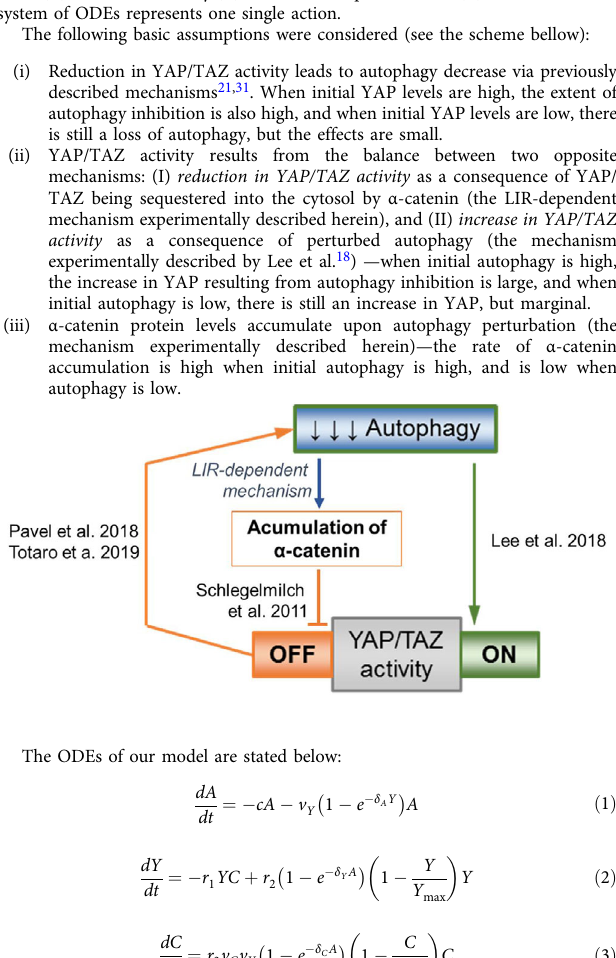
Fig. 10 α -Catenin intracellular protein levels direct the YAP/TAZ response to autophagy perturbations. a Representative immunoblots of CTNNA1 in multiple cell lines: MCF10A, HEK293T, HeLa, HepG2 after exposure to ATG7/10 siRNAs. Bars represent the mean ± s.e.m. ( n (from left to right) = 10/4/ 4/6 independent experiments; *** P < 0.001, * P < 0.05; two-tailed one sample t -test). b TEAD luciferase activity in MCF10A cells exposed to CTNNA1/ 3 siRNAs, followed by treatment with EBSS (6 h), as indicated. Bars represent the mean ± s.e.m. ( n = 6 independent experiments; *** P < 0.001, * P < 0.05; two-tailed one sample t -test). c TEAD luciferase activity in MCF10A cells exposed to CTNNA1/3 siRNAs, followed by treatment with Trehalose (100 mM, 24 h), as indicated. Bars represent the mean ± s.e.m. ( n = 9 independent experiments; *** P < 0.001, ** P < 0.01, * P < 0.05; two-tailed one sample t -test). d TEAD luciferase activity in MCF10A cells initially exposed to CTNNA1/3 siRNAs for 48 h followed by double ATG7/10 KD for other 48 h, as indicated. Bars represent the mean ± s.e.m. ( n = 6 independent experiments; ** P < 0.01; two-tailed one sample t -test). e TEAD luciferase activity in HepG2 cells transfected with mEm-empty or wild-type mEm-CTNNA1, and after, exposed to EBSS for 6 h. Bars represent the mean ± s.e.m. ( n = 4